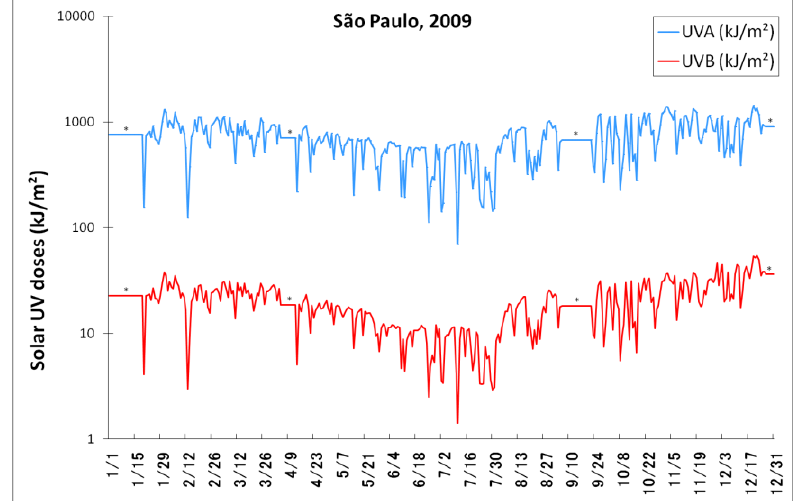
* Periods in which the measurements were not performed, due to technical